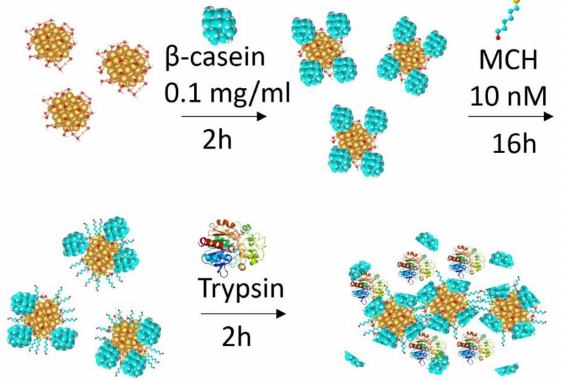
Figure 6. The scheme of modification of AuNPs by β -casein and by 6-mercapto-1-hexanol (MCH) as well as the cleavage of β -casein by trypsin. Before enzymatic digestion, functionalized AuNPs were stable due to steric stabilization. After the AuNPs were subjected to protease cleavage, the casein was removed from the surface of AuNPs/MCH/ β -casein. This caused the destabilization of the NPs, followed by their aggregation. Reproduced from